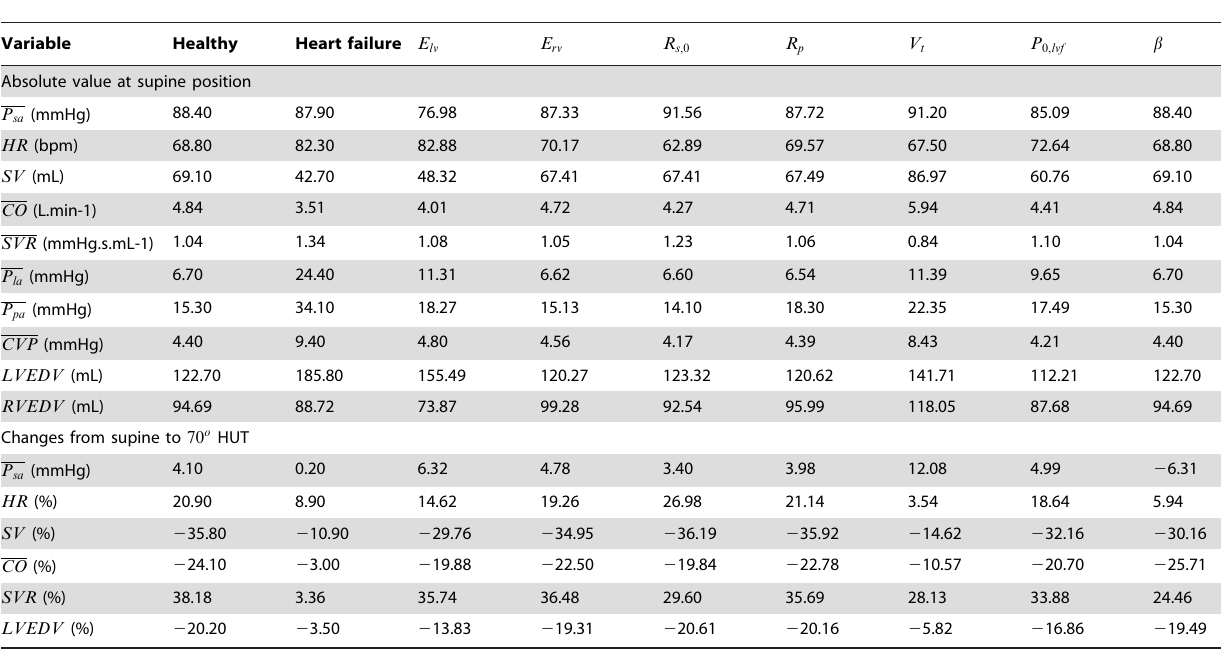
Table 5. Effect of individual parameter on key hemodynamic variables during supine and 70 o HUT.